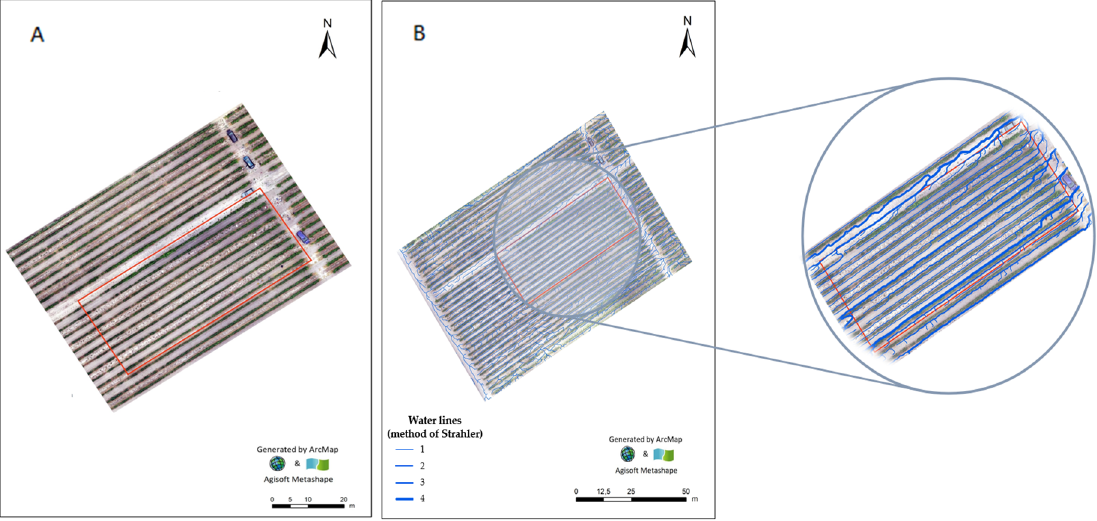
Figure 4. Orthophotomap ( A ) and map of the surface drainage network order of water lines, according to Strahler ( B ), of the vineyard with variety Fernão Pires. Red shows the limits of the field. Information collected before flowering and biofortification treatments.